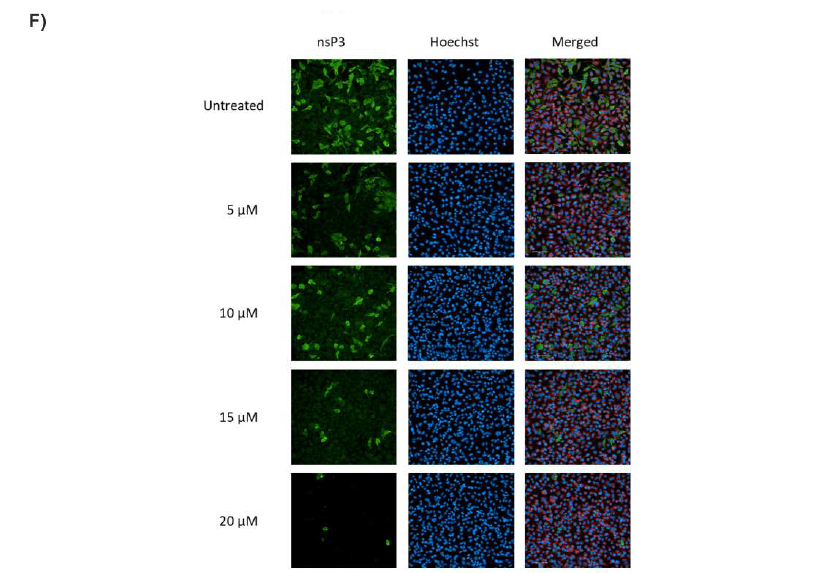
Figure 2. The dose–response of potent sphingosine kinase inhibitors for activity against CHIKV infection. ( A ) The chemical structures of the sphingosine kinase inhibitors positive for anti−CHIKV activity. ( B − E ) Positive candidates were further analyzed using a dose−response curve (5, 10, 15, 20 µM). HeLa cells were pre−treated for 1 h and then infected with CHIKV (MOI = 1) for 24 h. Staining was conducted for viral nonstructural protein (nsP3, green), nucleus (Hoechst33342, blue), and cytoplasm (CellMask, red). Images were obtained on the Operetta CLS confocal microscope (20 × objective), and analysis was conducted using the Harmony software. Data represent means ( ± SD) from one representative experiment of at least two independent experiments performed in duplicate. ( F ) Representative images of the SLL3071511 inhibition of CHIKV infection were collected using the Operetta CLS microscope (20 × objective).